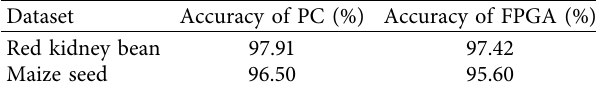
Table 4: Accuracy on diferent